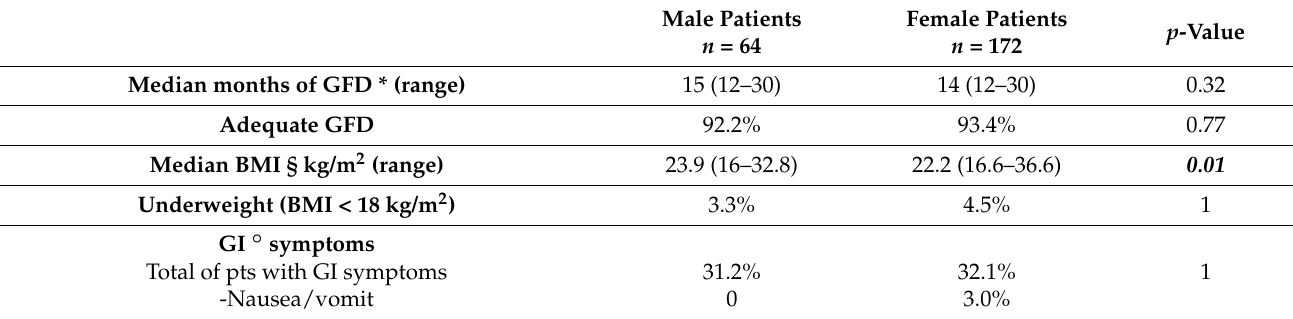
Table 3. Features and comparison between male and female patients at the time of the GFD follow-up. Male